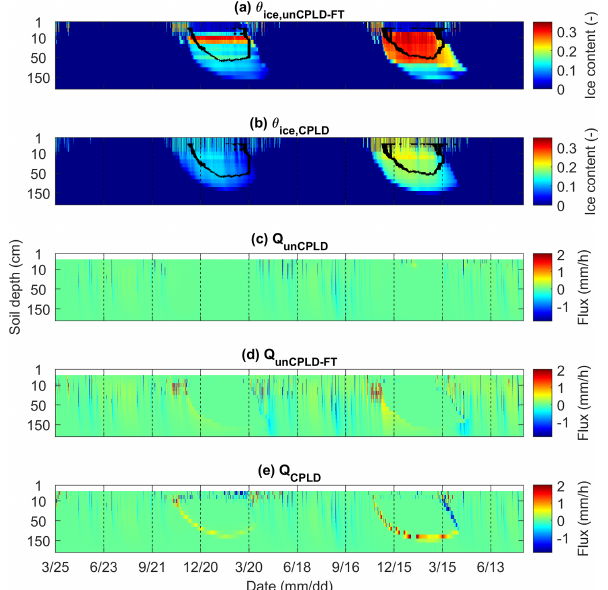
Figure 8. Soil ice content from (a) unCPLD-FT and (b) CPLD model simulations with freezing front propagation derived from the measured soil temperature and vertical water flux (positive value in- dicates upward water flow) from (c) unCPLD, (d) unCPLD-FT, and (e) CPLD model simulations. Note that soil ice content is not rep- resented in the unCPLD model and the fluxes in the top 2cm soil layers were not reported to highlight fluxes in the lower layers.